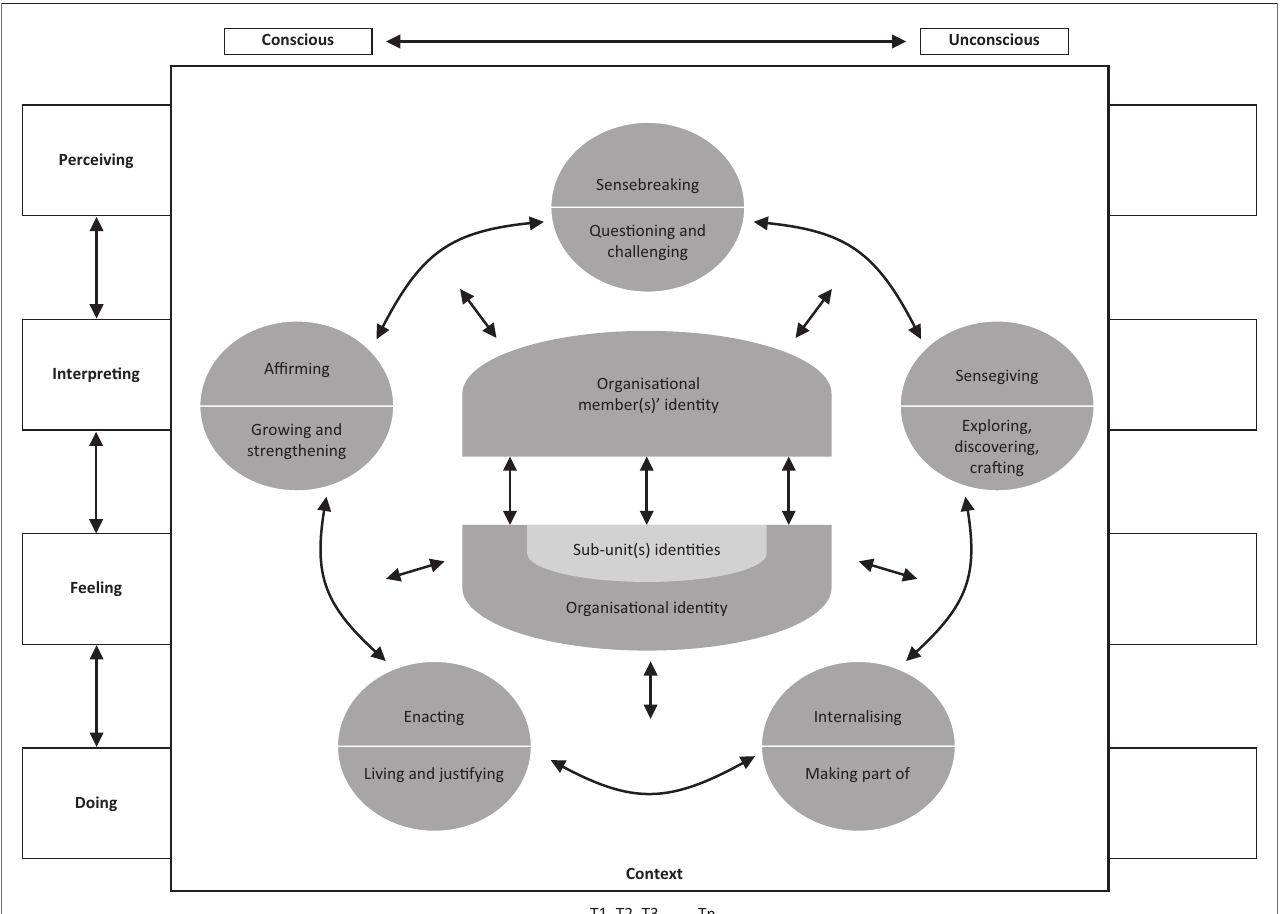
FIGURE 2: Ongoing, real-time recurring cycle of identity